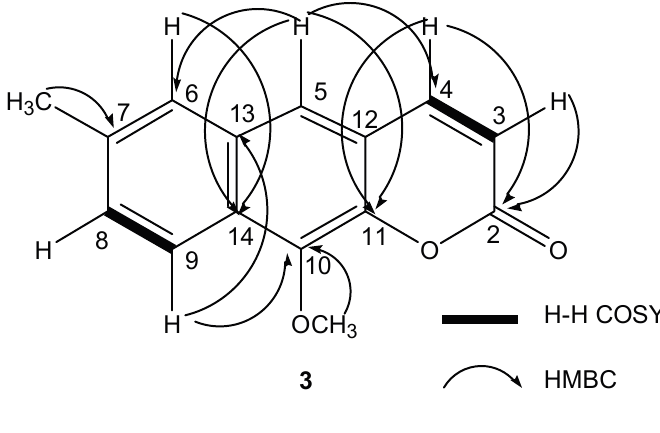
Figure 2. The structure of compound 3 and key assignments of its COSY and HMBC correlations